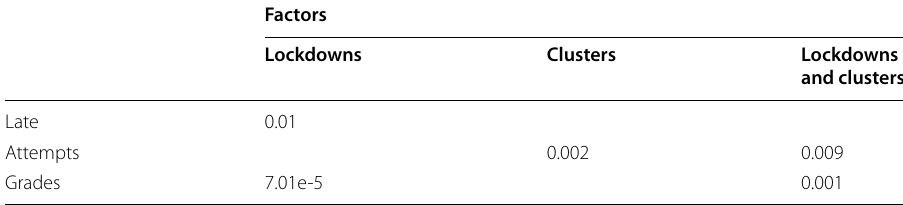
Table 7 p-values in Kruskal–Wallis test Factors